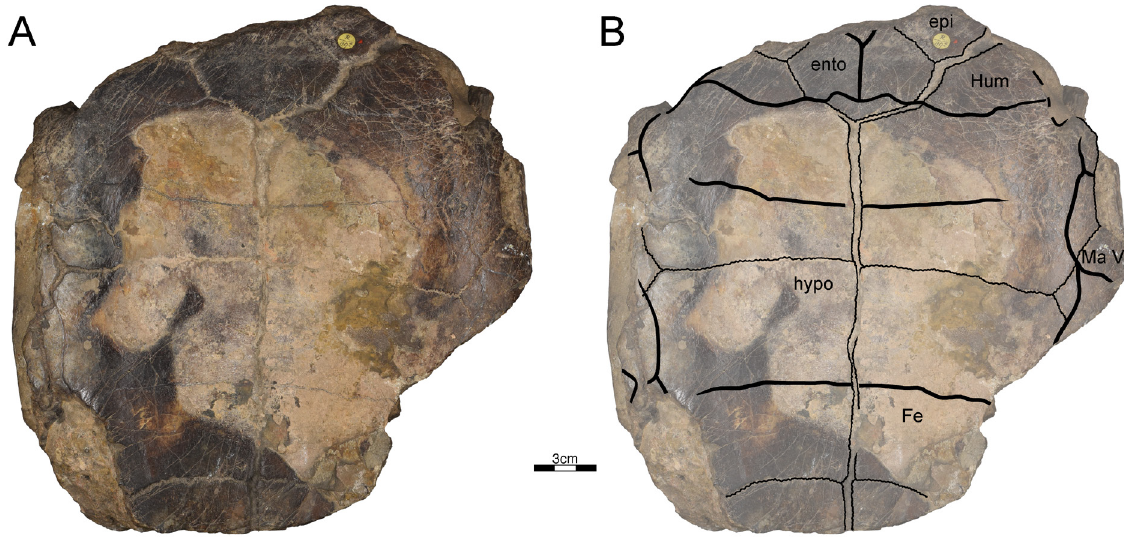
Fig. 26. BMNH R.892, referred to Damonia hamiltonii Gray, 1869 by Lydekker (1889b, under the number BMNH R.829), here identified as Geoclemys hamiltonii (Gray, 1830). A . Photograph of plastron. B . Illustration of plastron. Scale bar: